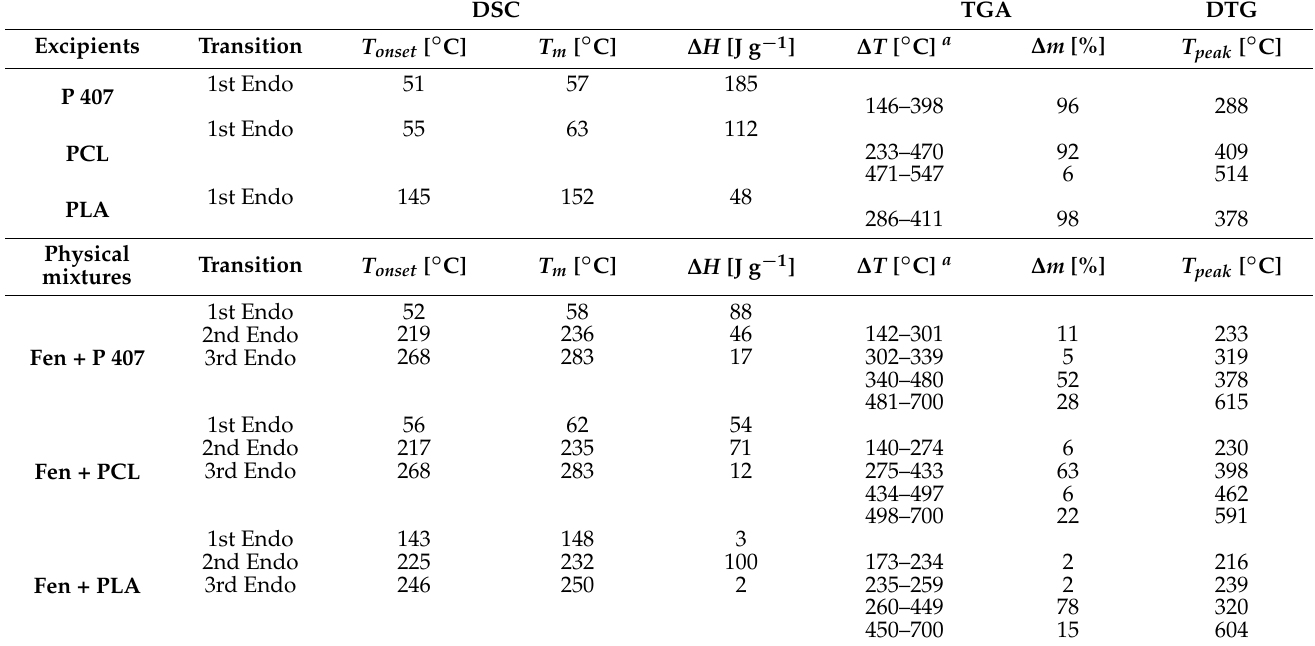
Table 1. Thermoanalytical data of neat excipients and physical mixtures between Fen +